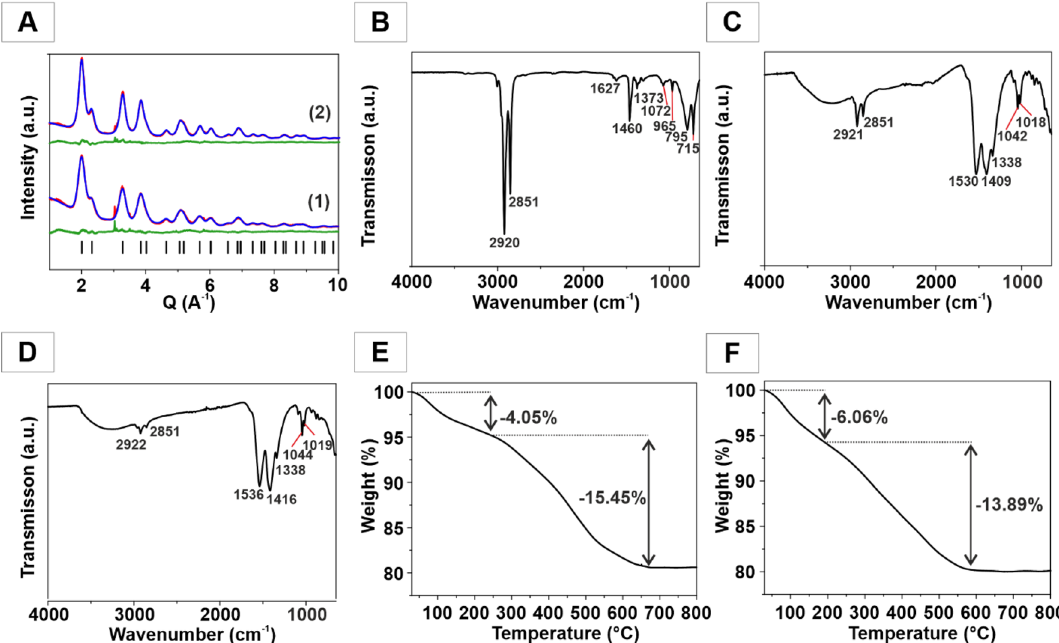
Figure 2. ( A ) X-ray powder diffraction patterns with Rietveld refinements of CeO 2 NPs obtained by batch synthesis (1) and under segmented flow conditions (2). Experimental data (red line), Rietveld refinement (blue line), difference curve (green line). Ticks indicate theoretical positions of Bragg intensities. FT-IR spectra of ( B ) pure oleylamine, ( C ) CeO 2 NPs obtained from batch chemistry, and ( D ) under segmented flow conditions. TGA traces of CeO 2 NPs obtained under ( E ) batch and ( F ) segmented flow